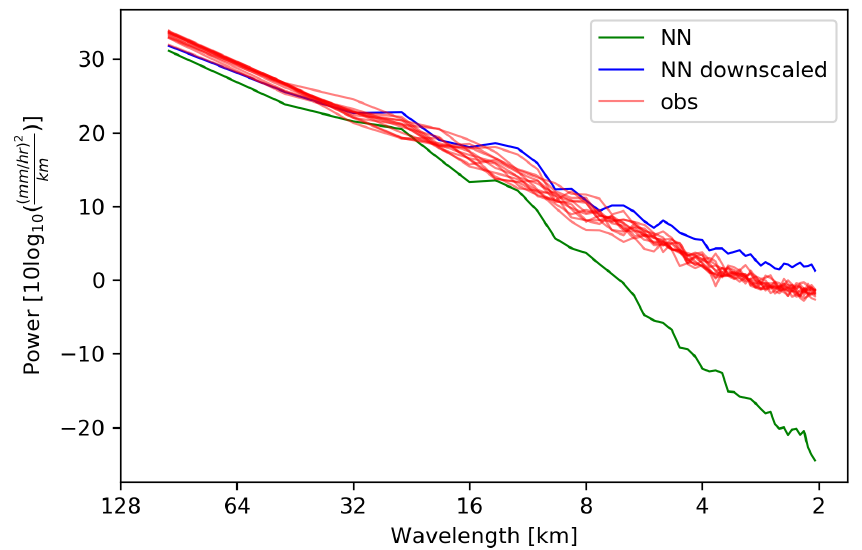
Figure 4. In red, the power spectrum for the 12 images at 5’ intervals of the precipitation field in the hour preceding the nowcast; in green, the power spectrum of the PredNet estimate for the image preceding the nowcast; in blue, the spectra of the field obtained by downscaling the NN output field using the procedure described in the paragraph 2.3